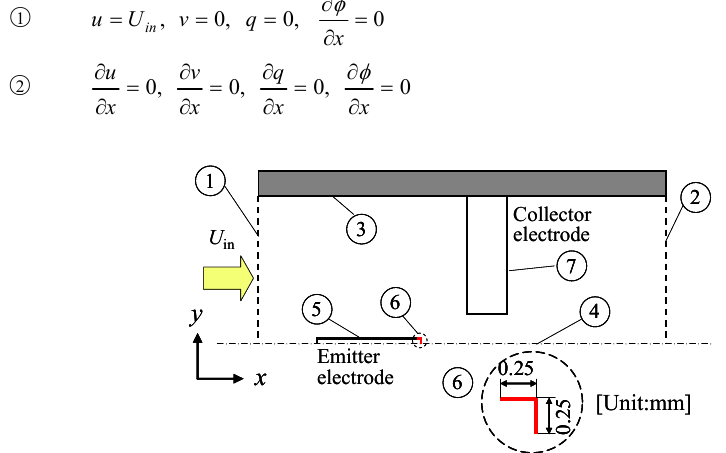
Fig.4 Boundary conditions for numerical